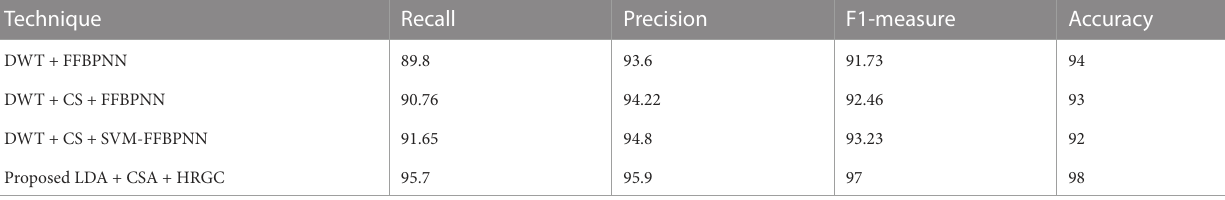
TABLE7 Comparativeanalysisofrecall,precision,F1-measure,andaccuracy(Sharma et al.,2021b). Technique